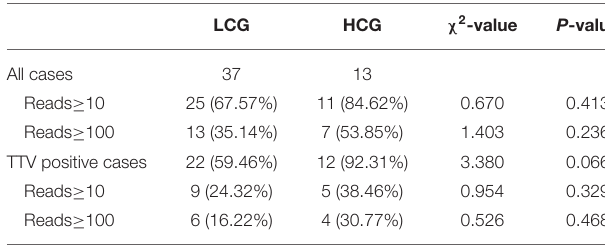
TABLE 3 | Relationship between tacrolimus concentration and viral infection.